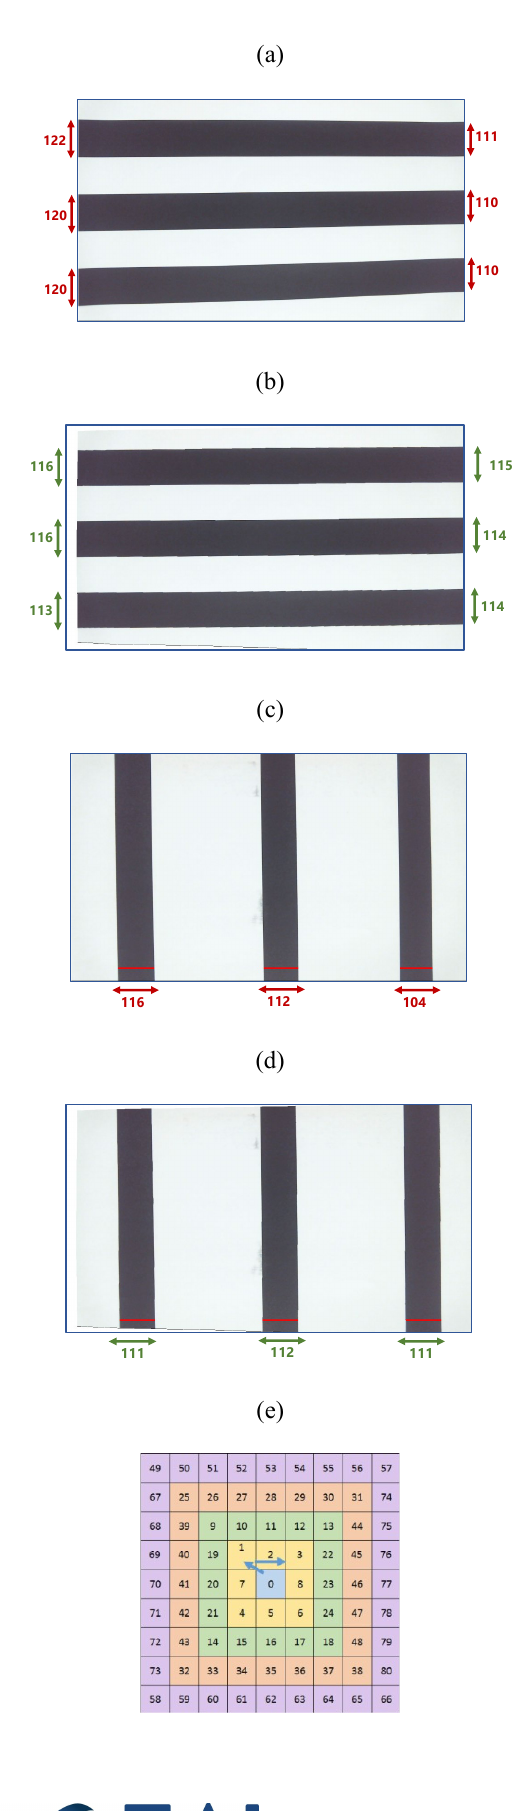
Figure 8. (a) Horizontal stripes before calibration; (b) Horizontal stripes after calibration; (c) Vertical stripes before calibration; (d) Vertical stripes after calibration; (e) Scanning